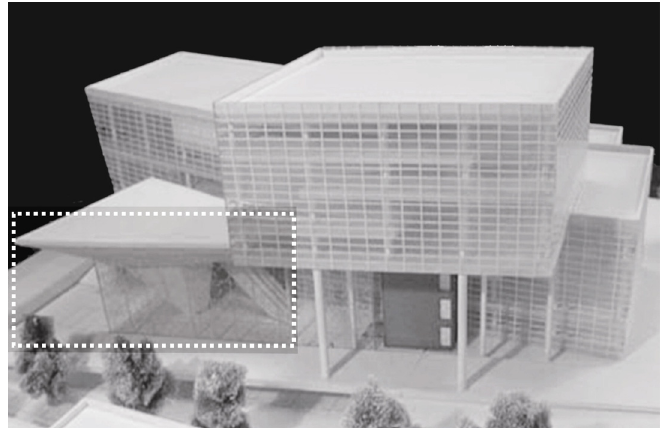
Figure 1: Model of the new building of the INHolland Polytechnic in Delft designed by Rijk